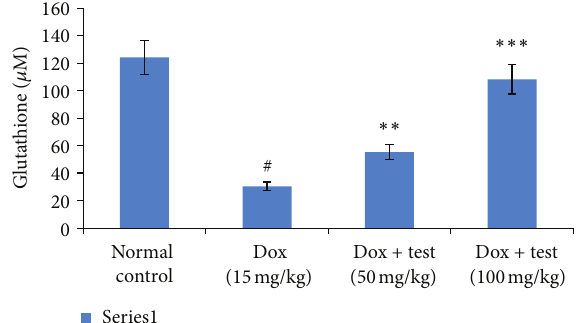
Figure 5: Effect of test compound on catalase levels in heart tissue homogenate in rats treated with doxorubicin. # 𝑃 < 0.001 versus normal control; ∗ 𝑃 < 0.05 versus dox; ∗∗ 𝑃 < 0.01 versus dox.